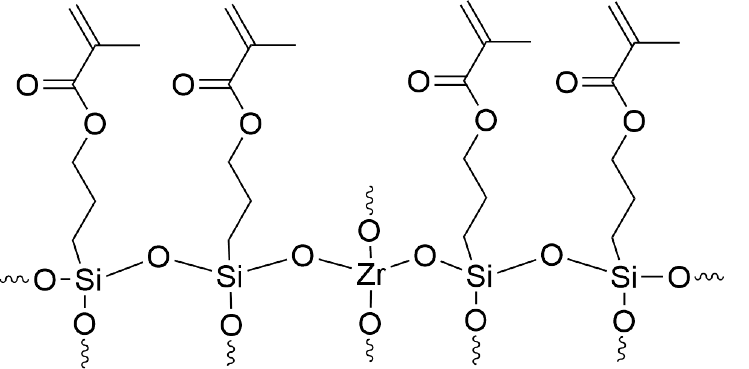
Figure A1. Simplified formula of SZ2080 for a MAPTMS:ZPO ratio of 8:2, the order of the monomers is for illustration